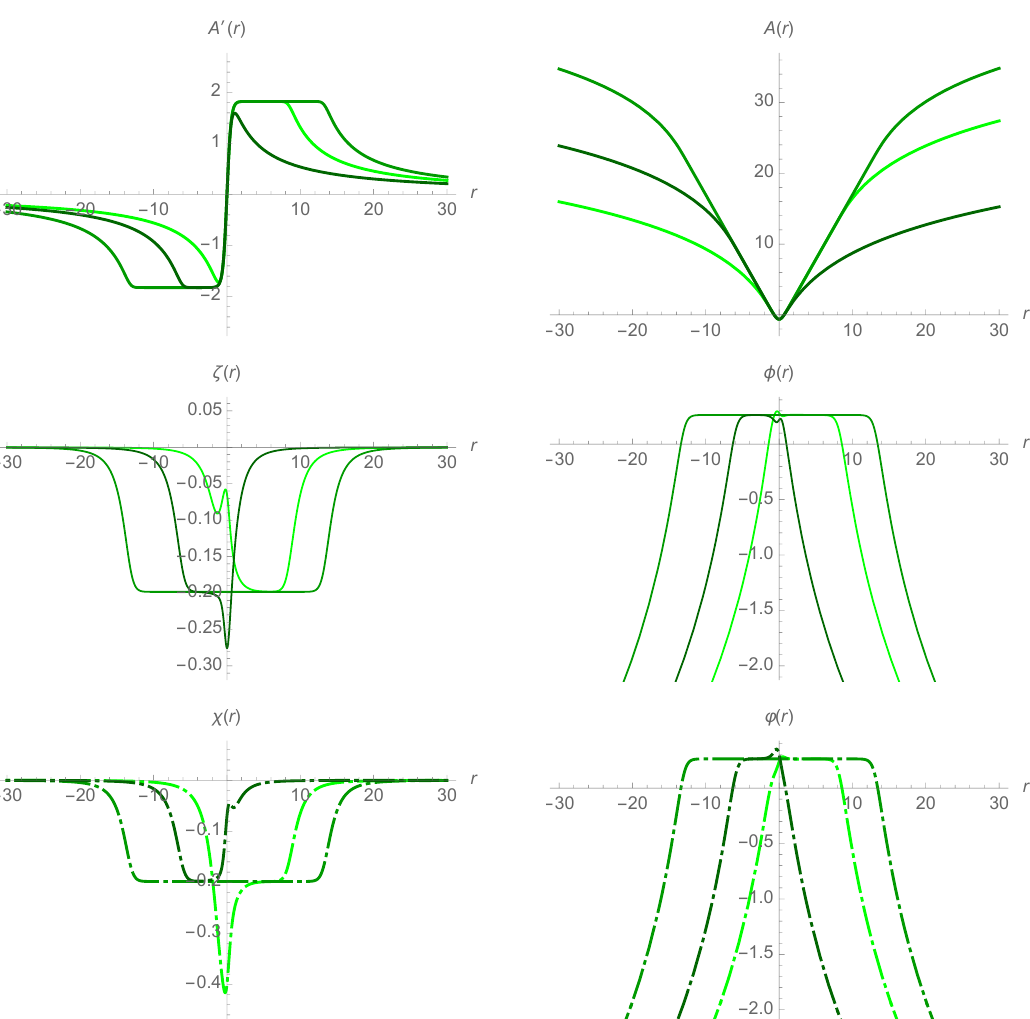
Figure 13. Examples of G 2 /SYM (dark green), SYM/ G 2 (light green) and G 2 / G 2 (green) N = 1 Janus solutions with SU(3)